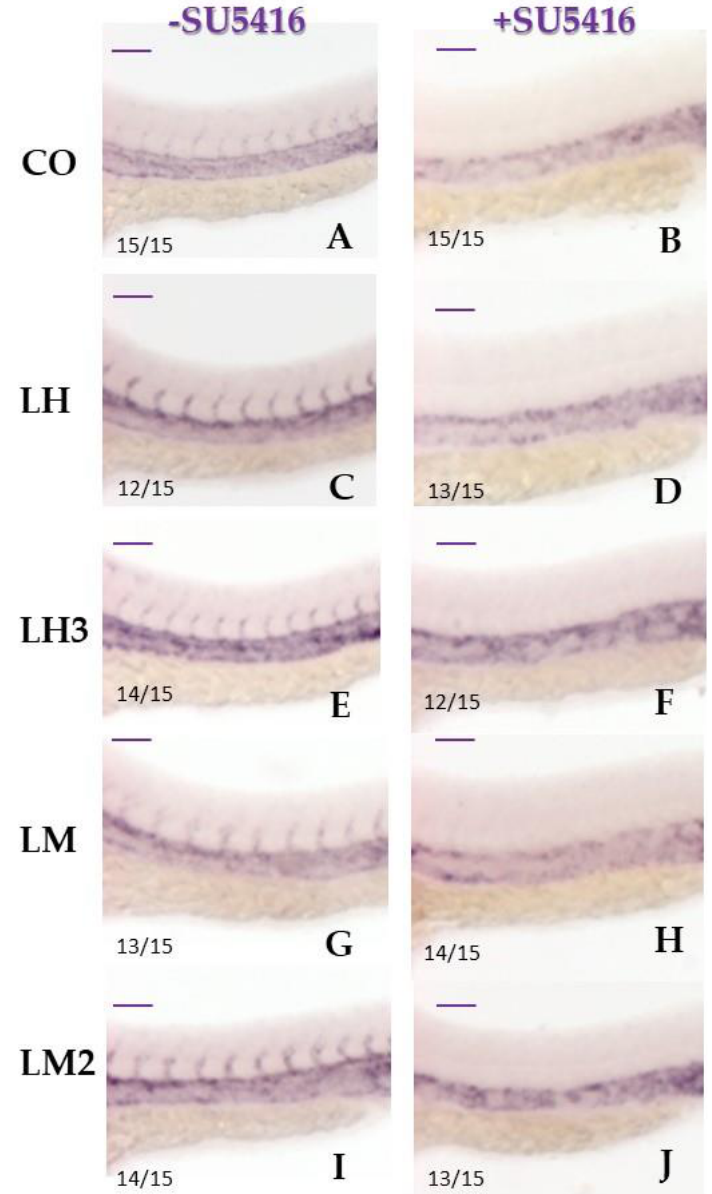
Figure 7. Pretreatment with a VEGF pathway inhibitor prevented the formation of intersomitic vessels: The panels show representative images of a WISH assay performed with fli1 as an endothelial marker, at 36 hpf, in untreated ( A , C , E , G , I ) and treated embryos ( B , D , F , H , J ) with SUGEN 5416. Previously, some embryos were treated with snail derivatives via Method I and controls with fish water and 0.1% DMSO (see Materials and Methods, Sections 3.4 and 3.5). Magnification of the trunk region (32×). Two replicates were performed ( n = 15). Ratios at the bottom-left part of each picture specify the number of embryos showing the same staining pattern, compared to the total number of embryos used for each experiment. The images were taken in lateral position at 32× magnification with a Zeiss Axiozoom V13 (Zeiss, Jena, Germany) microscope, equipped with a PlanNeoFluar Z 1×/0.25 FWD 56 mm lens and Zen Pro software.